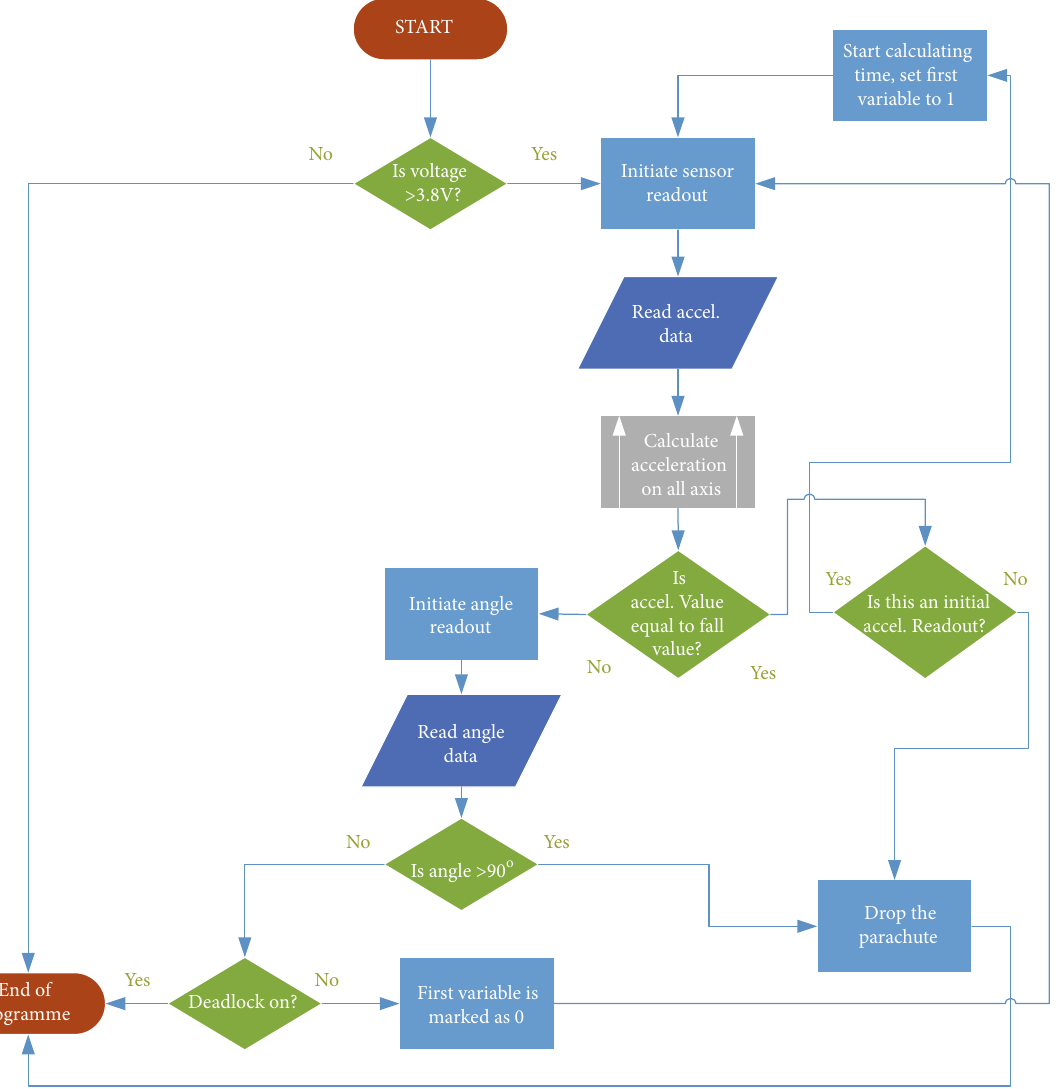
Figure 9: Parachute system operation